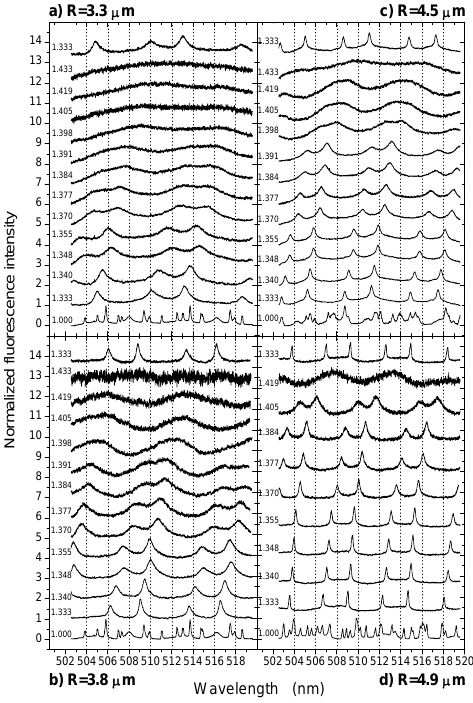
Figure 2. WGM spectra of four different beads of differing radii in dependence of the fluid index, n , of the DI water/glycerol mixture injected into the microfluidic flow cell. The fl spectra are labeled with their respective fluid indices as calculated from [19] and are vertically displaced for